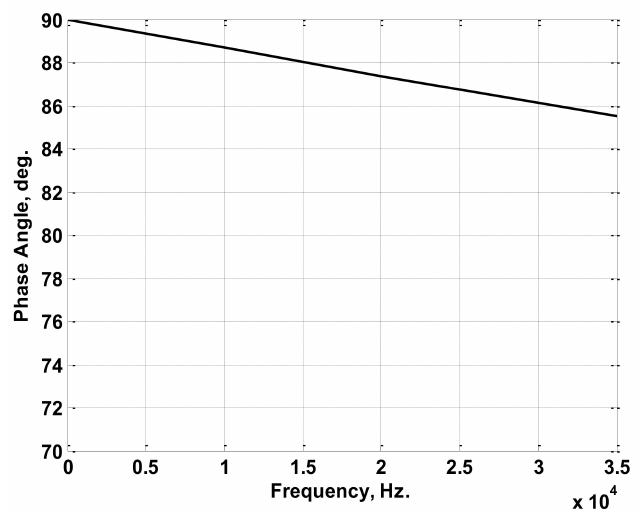
Figure 10. Maximum Terminal Voltages versus Frequency Characteristics of the Experimental Coil.